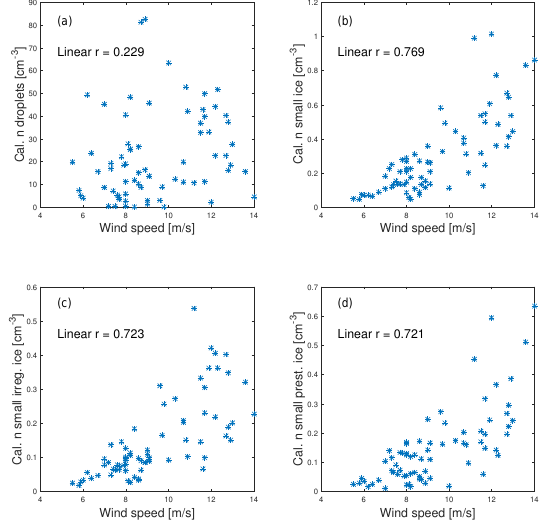
Figure 14. Correlation analysis of droplets as well as small ice par- ticles ( D p < 20µm) and the wind speed for the period displayed in Fig. 13. The figure shows as a function of the wind speed: the cal- culated droplet number concentration (a) , the calculated small ice number concentration (b) , the calculated small irregular ice number concentration (c) , and the calculated small pristine ice (columnar and hexagonal) number concentration (d) . In each plot the correla- tion coefficient, r , assuming a linear dependence is